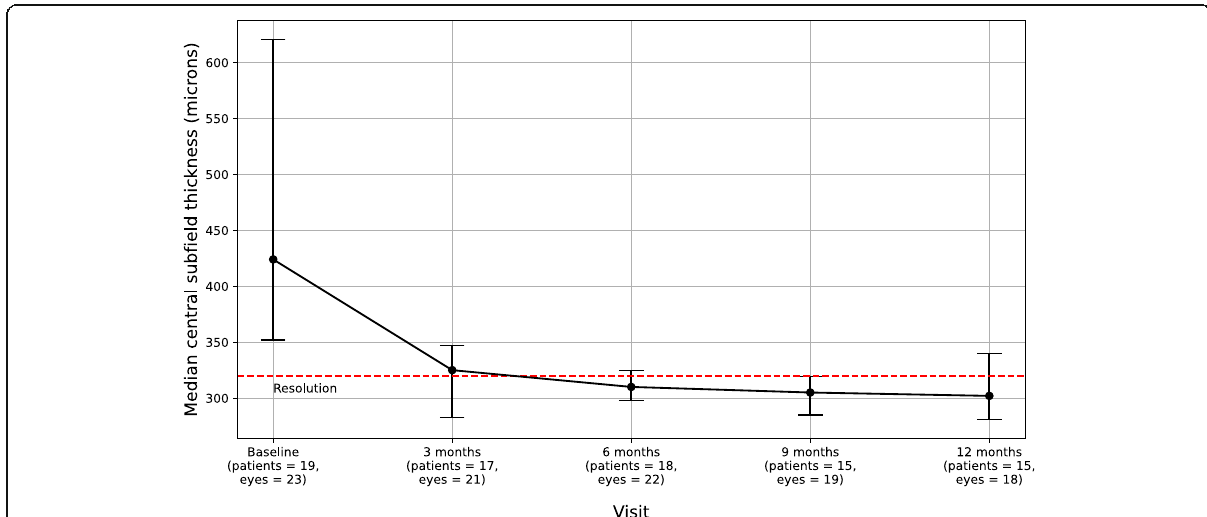
Fig. 2 Central macular thickness changes over 12 Months. 55.6% achieved macular edema resolution by the 3-month mark. Two patients (1 with bilateral uveitis, 1 with unilateral) did not have OCT imaging at their baseline visit but were noted in their medical record to have macular edema from OCTs done by the referring clinic. Given that this is a retrospective chart review study, OCT data availability varied at different timepoints depending on the whether the provider ordered OCTs based on their clinical suspicion of macular